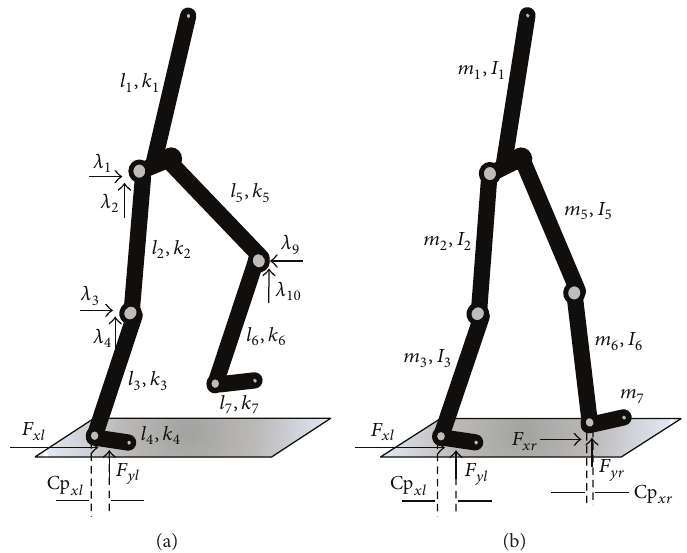
Figure 5: Forming constraints on single support (a) and double support